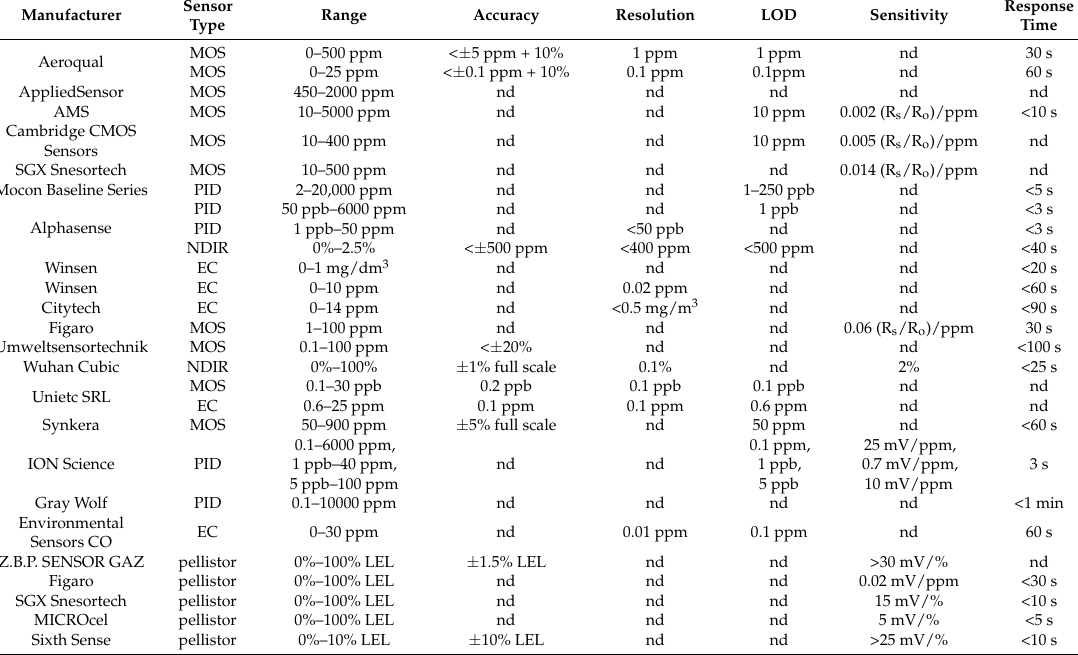
Table 5 gathers basic information about the types of commercially available sensors for measurement of toxic gases and flammable gasses from the VOCs group and their metrological parameters. The mentioned parameters include (unless the information was unavailable): measurement range, measurement accuracy, resolution, limit of detection, sensitivity and response time. Table 5. Commercially available chemical sensors for measurement of volatile organic